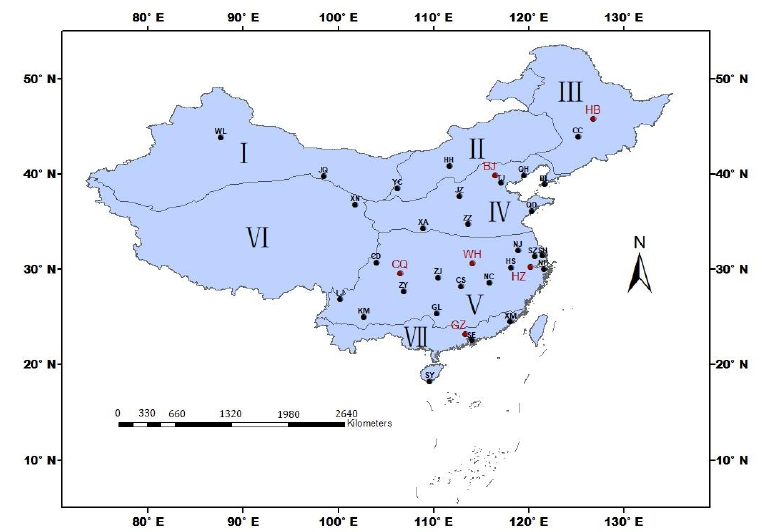
Figure 1. Distribution of the large tourist cities in this study. The cities with red color are used for exploring optimal methods on solar radiation estimation, and the cities with black color are the other tourism cities in this study. Roman numerals indicate the climate zones in China. I denotes the temperate and warm-temperate deserts of northwest China, II Inner Mongolia, III the temperate humid and sub-humid northeastern China, IV the temperate humid and sub-humid northern China, V the subtropical humid central and southern China, VI the Qinghai–Tibetan Plateau, and VII the tropical humid southern China. Whole names of the cities can be seen in Table